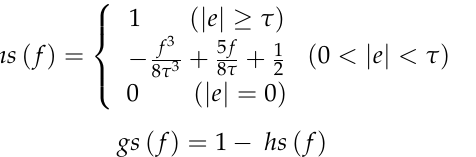
Figure 2. Variation of coefficients when (cid:2028) = 0.1.